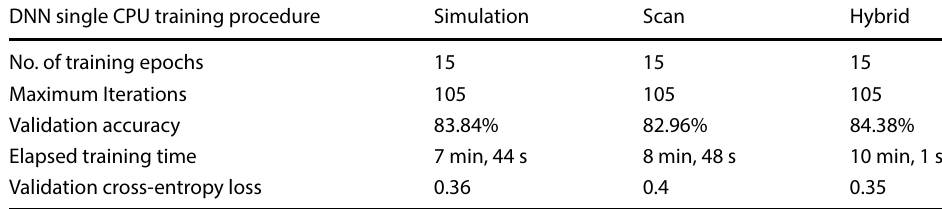
Table 1 DNN-Training performance average value of 5 training